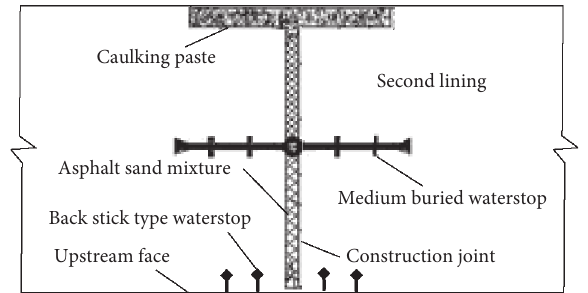
Figure 18: Structural sketch of absorbing joint in second